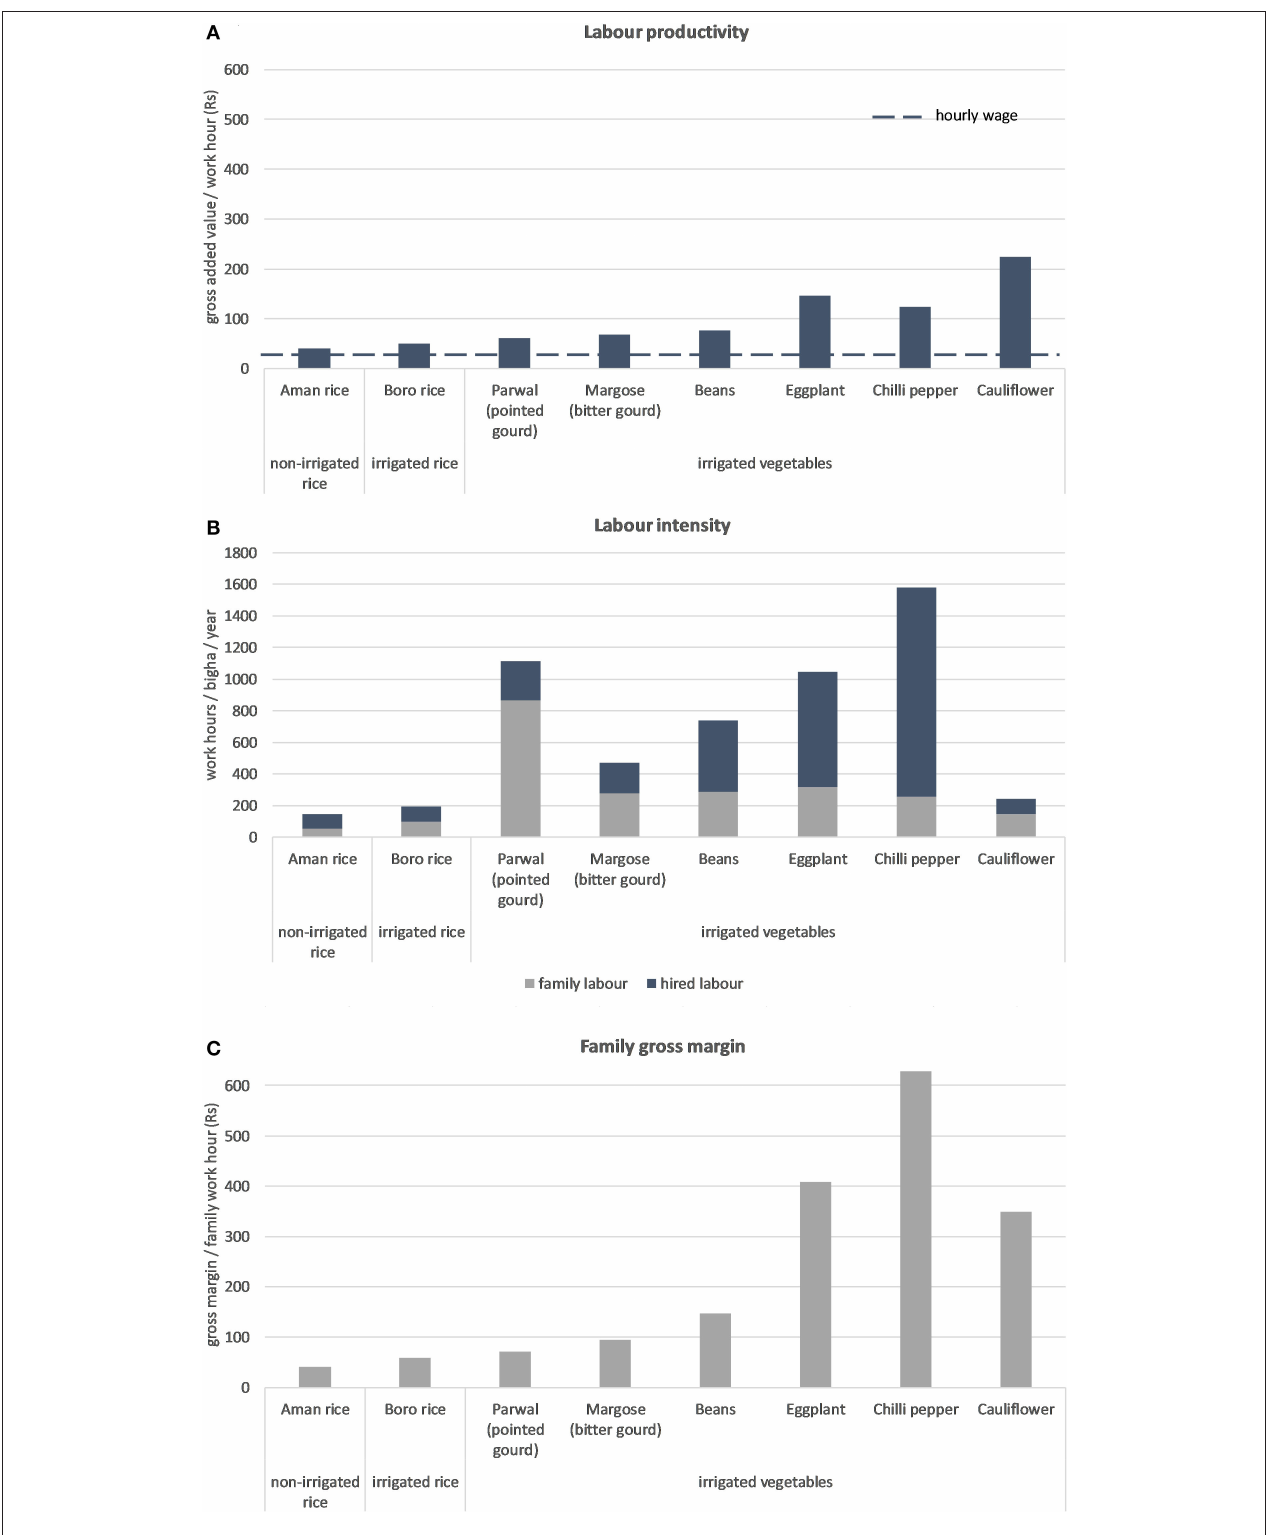
FIGURE 7 | Labor productivity (A) , work time (B) and gross margin per hour of family labor (C) for eight cropping systems in Bangaon, West Bengal (1 bigha = 0.1350 ha) Source: C. Aubron, S. Bainville and O. Philippon based on agrarian diagnoses IndiaMilk project (Josse, 2018).